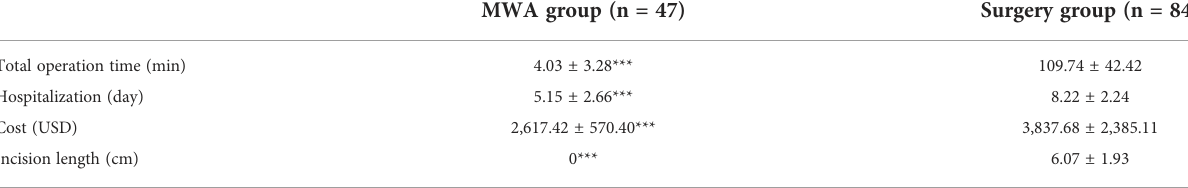
TABLE 5 Treatment time and medical cost of patients with Bethesda category IV thyroid nodules treated with MWA and